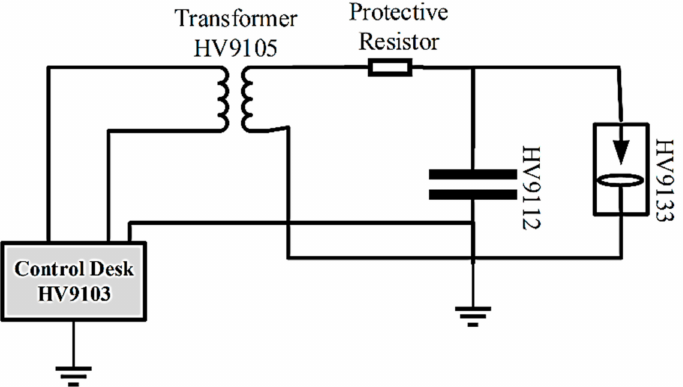
Figure 7. Schematics for AC setup.